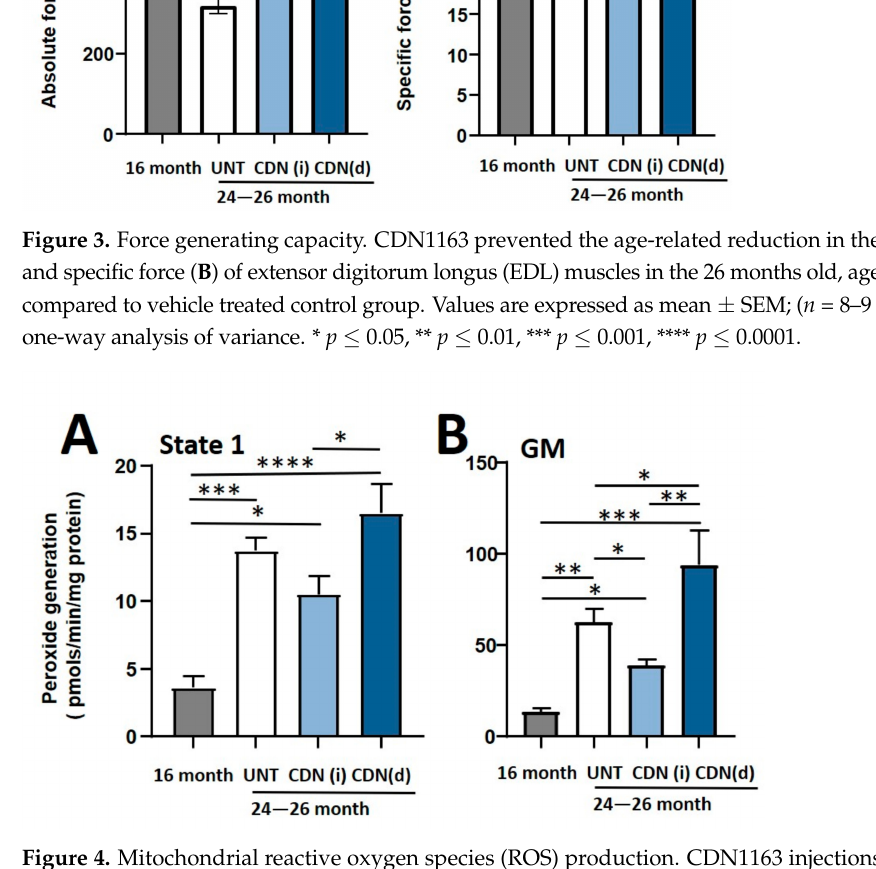
Figure 4. Mitochondrial reactive oxygen species (ROS) production. CDN1163 injections but not diet reduced the mitochondrial ROS production during state-1 ( A ) (without mitochondrial substrate) and in the presence of respiratory substrates ( B ) (glutamate/malate; G/M) in the gastrocnemius muscles of 26-month-old aged mice when compared to vehicle treated control group. Values are expressed as mean ± SEM; ( n = 8–9 mice/group); one-way analysis of variance. * p ≤ 0.05, ** p ≤ 0.01, *** p ≤ 0.001, **** p ≤